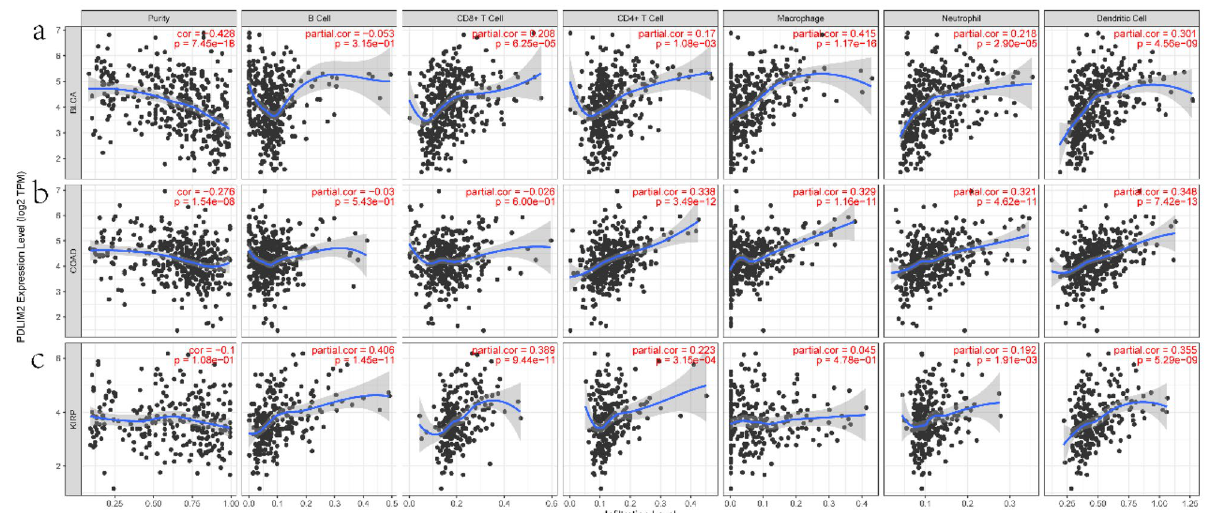
Figure 5. PDLIM2 expression level has significant positive correlations with immune infiltration level by TIMER database(https:// cistr ome. shiny apps. io/ timer/) in BLCA, COAD and KIRP, ( a ) in BLCA, ( b ) in COAD, ( c ) in KIRP. BLCA: bladder urothelial carcinoma; COAD: colon adenocarcinoma; KIRP: kidney renal papillary cell